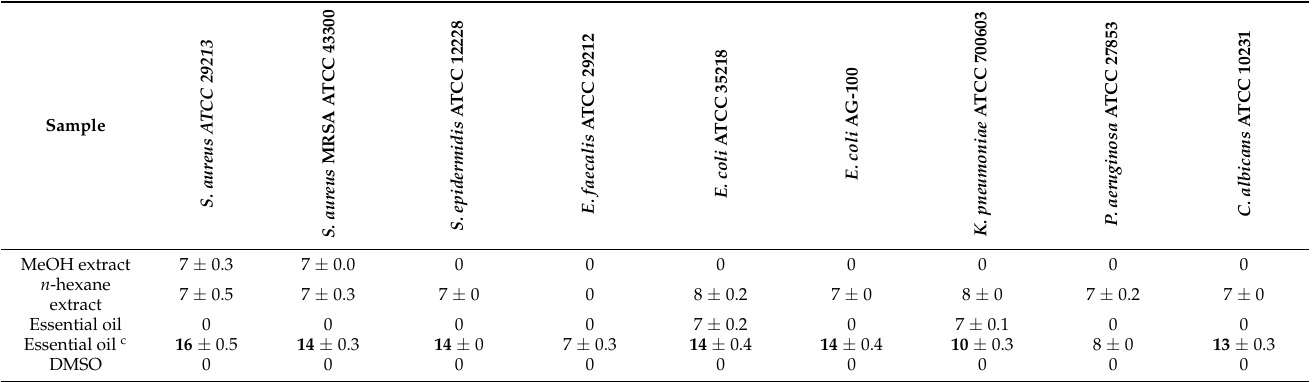
Table 2. Antimicrobial activities of marjoram samples at 50 µ g/mL concentration by agar disc